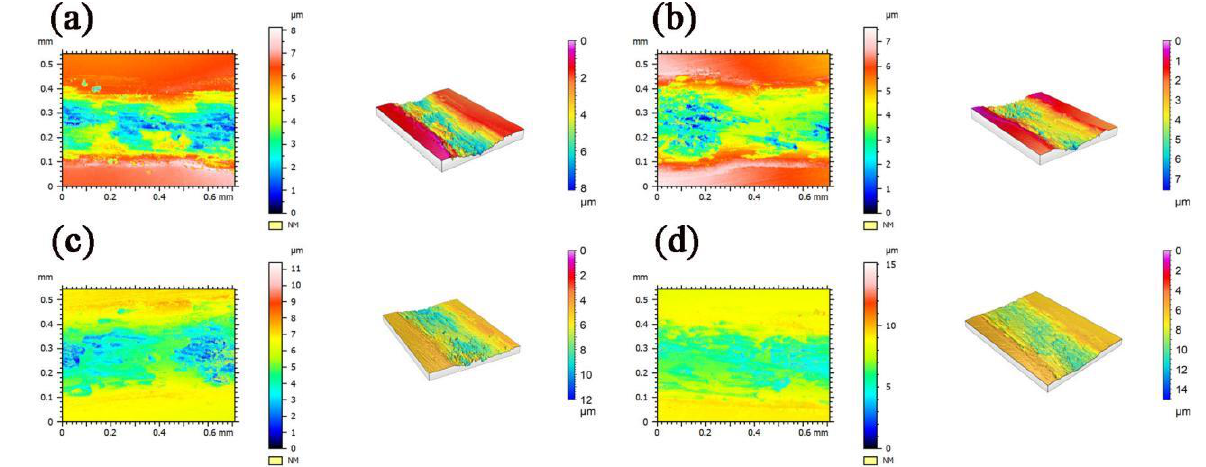
Figure 7. 3D non-contact surface mapping of the wear scars: ( a ) 25 °C; ( b ) 500 °C; ( c ) 600 °C; ( d ) 700 °C.